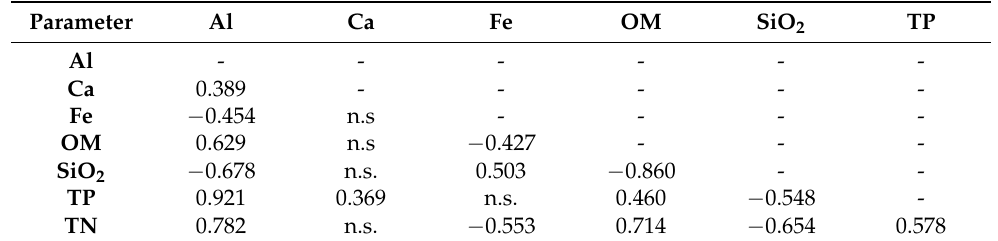
Table 2. Correlation matrix between bottom sediment components of Starodworskie Lake ( n = 30, p < 0.05)